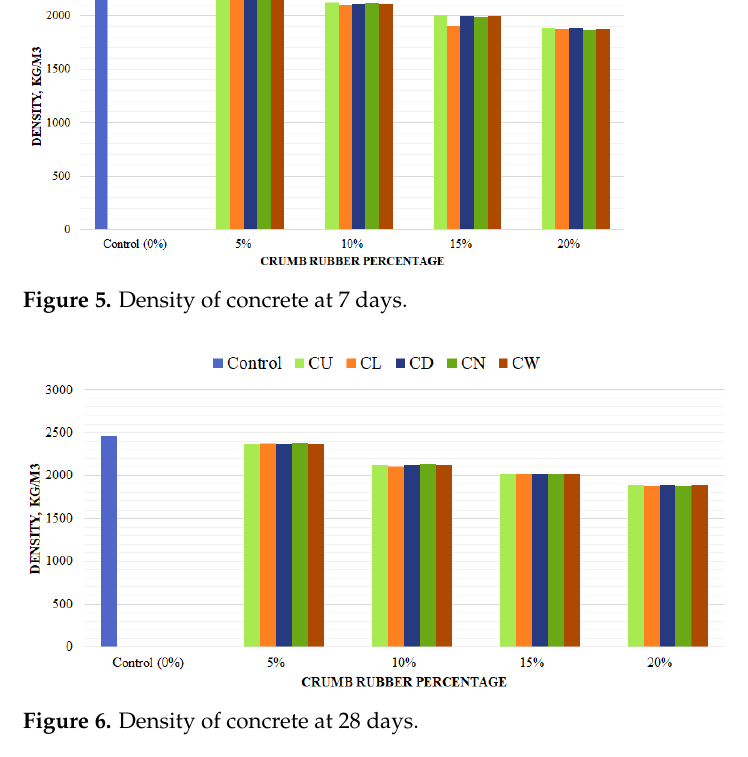
Figure 6. Density of concrete at 28